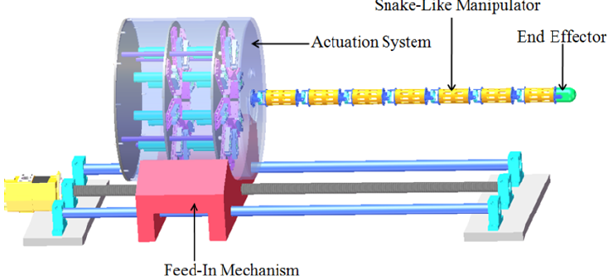
Figure 3. The CDSLM robot system.